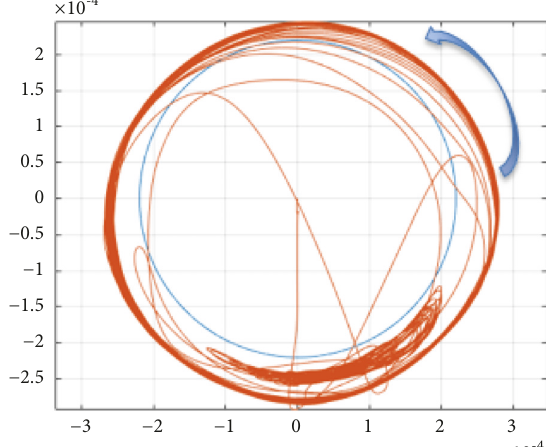
Figure 25: Predicted rotor horizontal forces during a radial landing test (DE node).